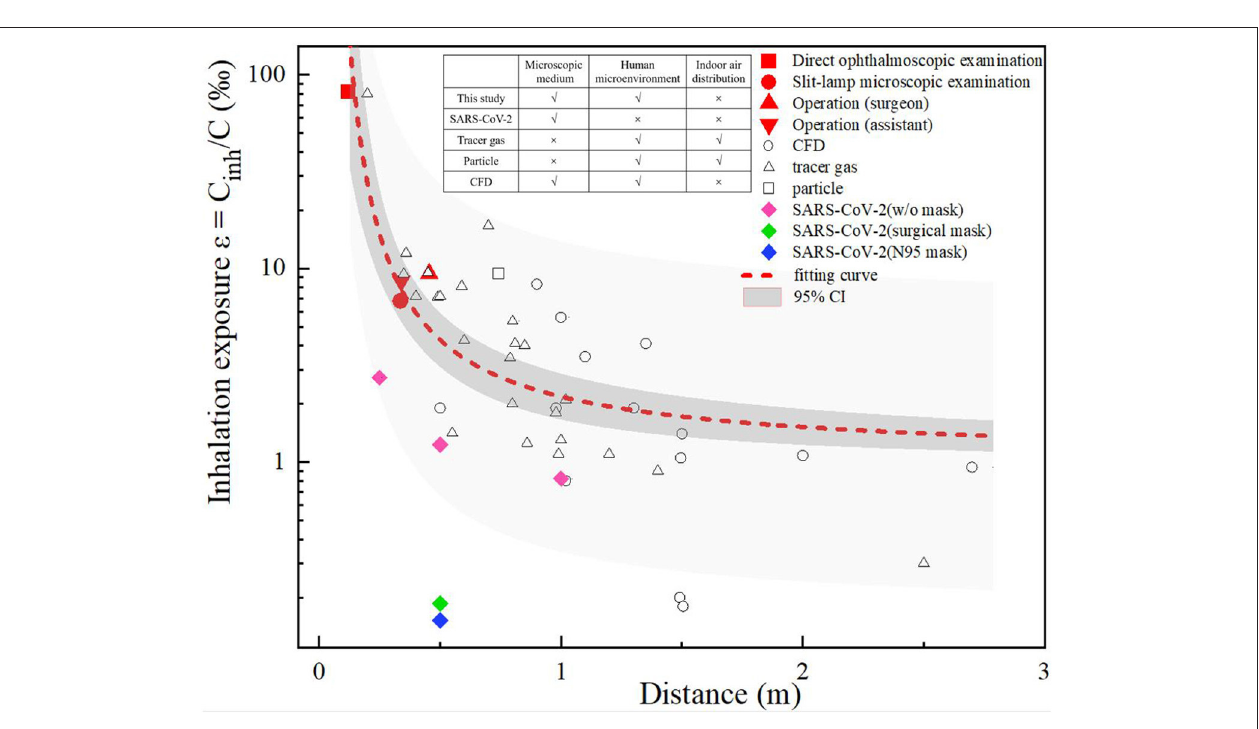
FIGURE 3 | Inhalation exposure of ophthalmologists’ compared to previous